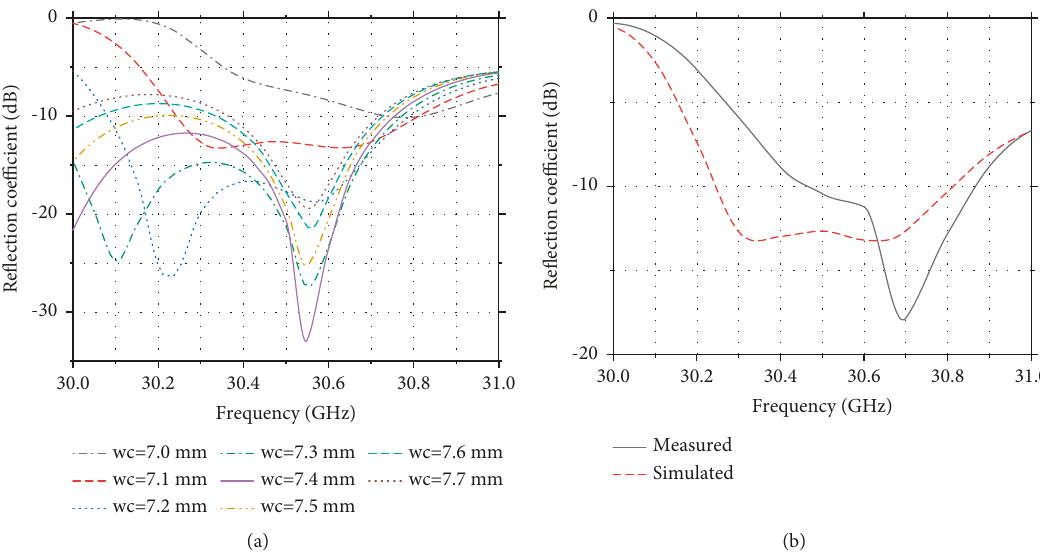
Figure 10: (a) Simulated reflection coefficients of the 2 and simulated reflection coefficients of the 2